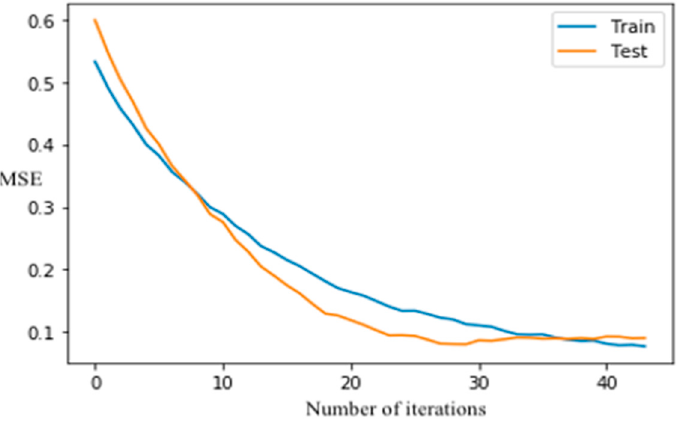
Figure 6. XGBoost classification error vs. the number of iterations.